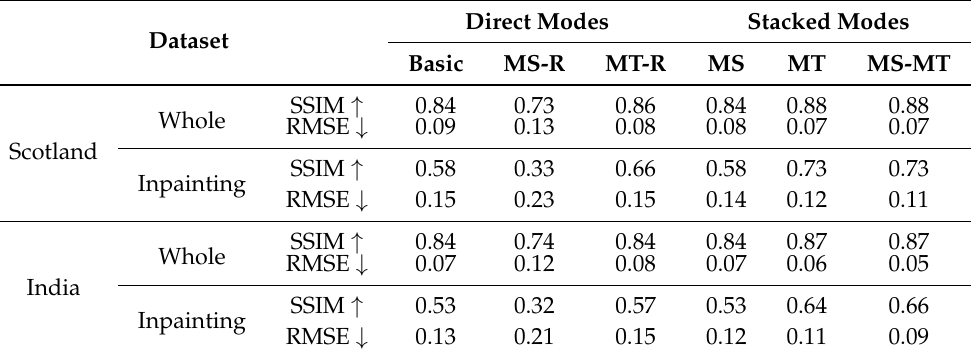
Table 2. MS—Multi-Source (Sentinel 1), MT—Multi-Temporal, -R—Residual Variants. Optimal performance maximizes SSIM and minimizes RMSE. This occurs for the modes using temporal support data, with the MS-MT mode surpassing all others for both datasets and both for the inpainting region and the whole